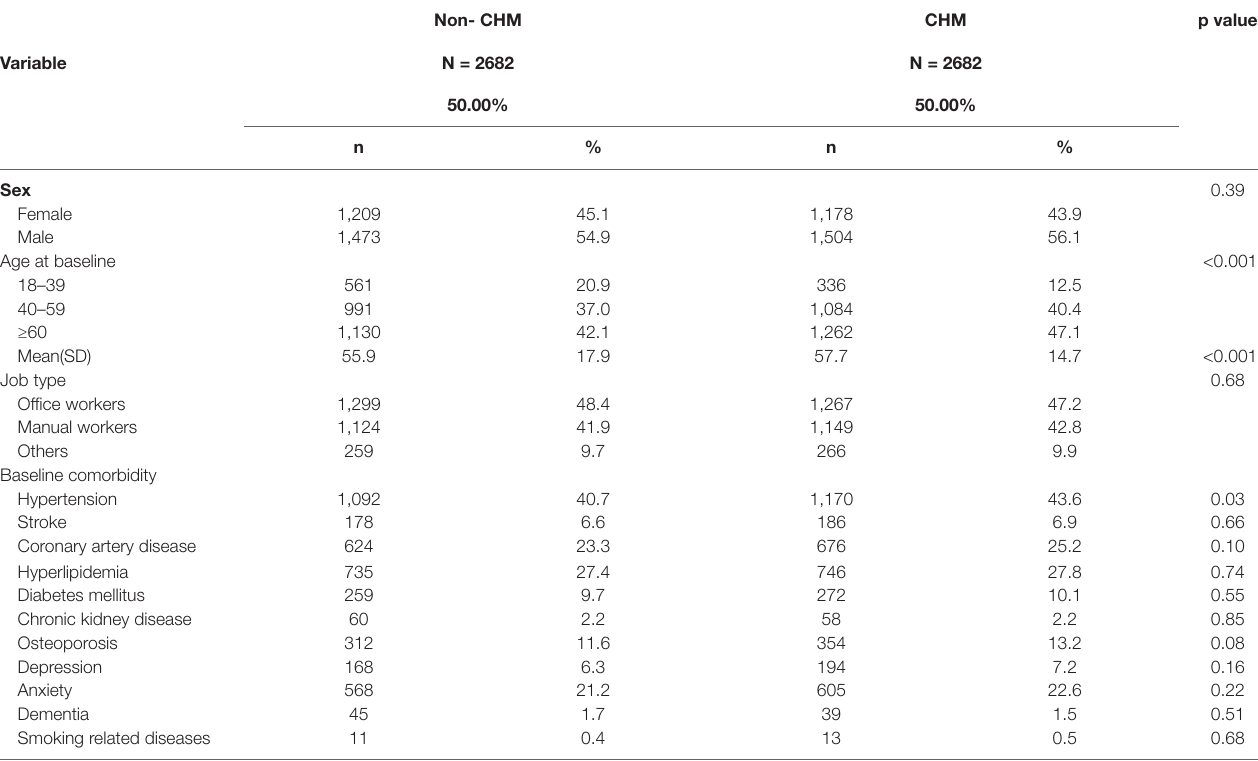
TABLE 1 | Demographic characteristics and comorbidities of patients newly diagnosed with COPD in Taiwan during 2000–2010.